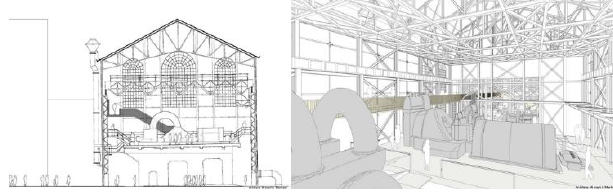
Figure 13. Less intervention and the visibility of structure from inside.